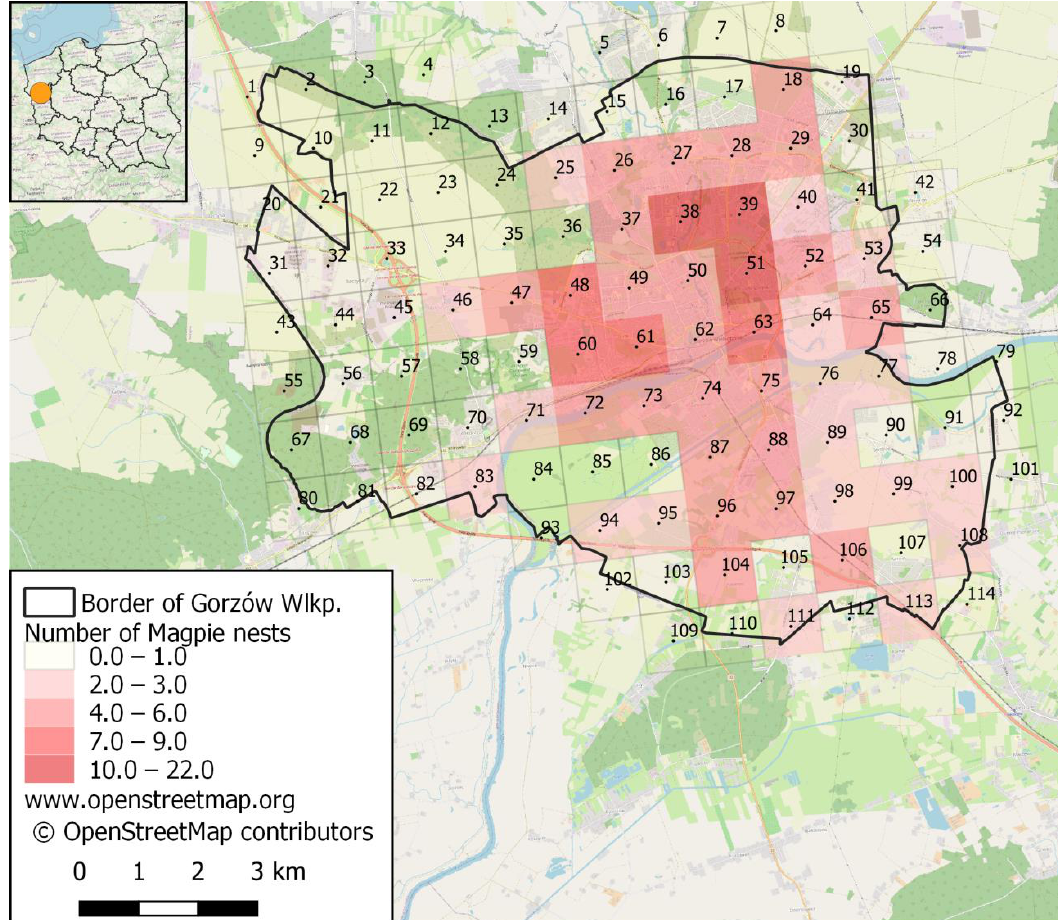
Figure 1. Spatial distribution and density of Magpie nests in the study area, divided into squares ( n = 114) of 1 × 1 km.